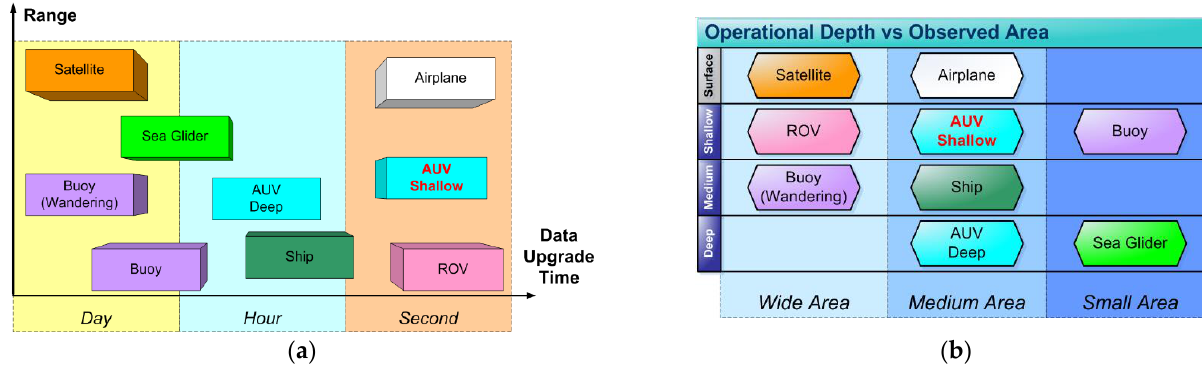
Figure 1. In these two figures are presented the most important classes of vehicles for sea exploration and their perfor- mances ( a ) range vs. data upgrade time; ( b ) operational depth vs. observed area. ( a ) range vs. data upgrade time; ( b ) operational depth vs. observed